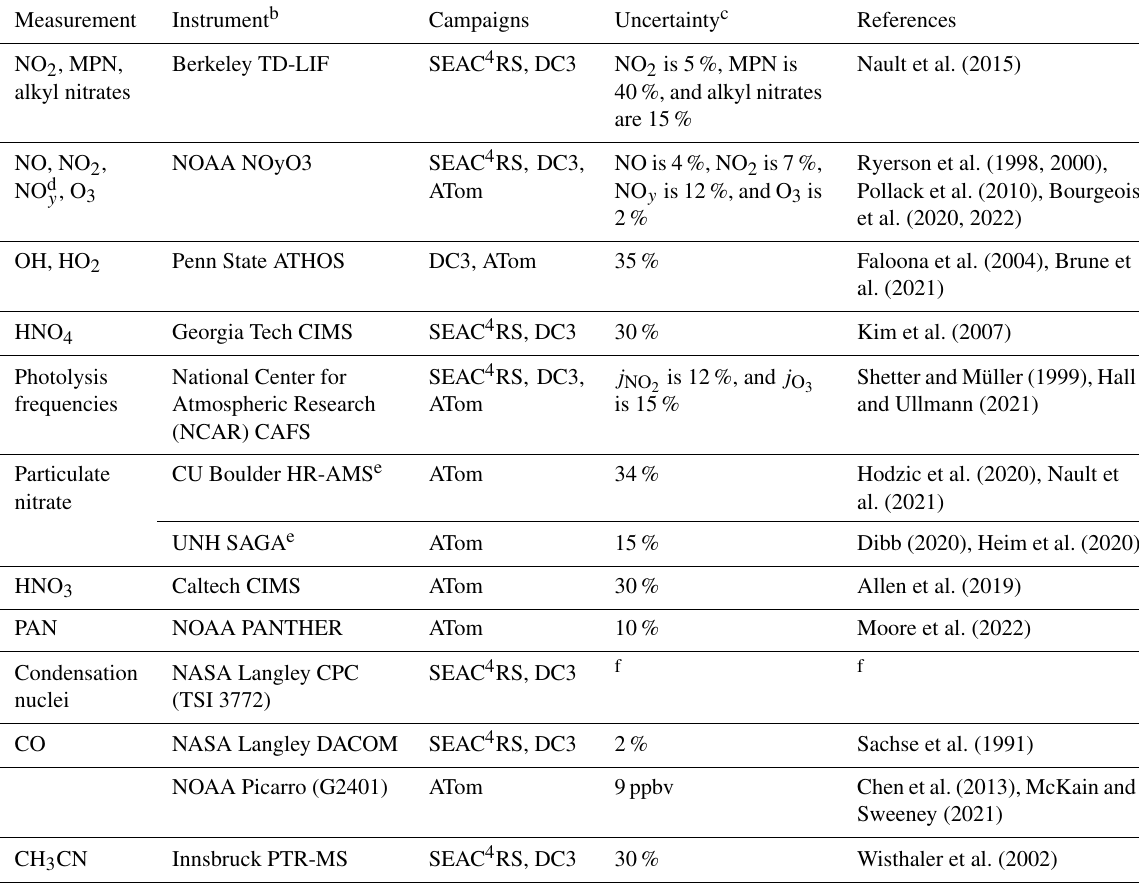
Table 1. Measurements from the SEAC 4 RS, DC3, and ATom aircraft campaigns a .